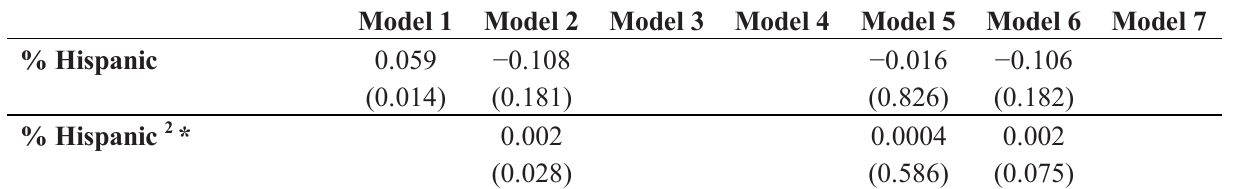
Table 3. Robust regression analysis results for county-level percent obesity † .